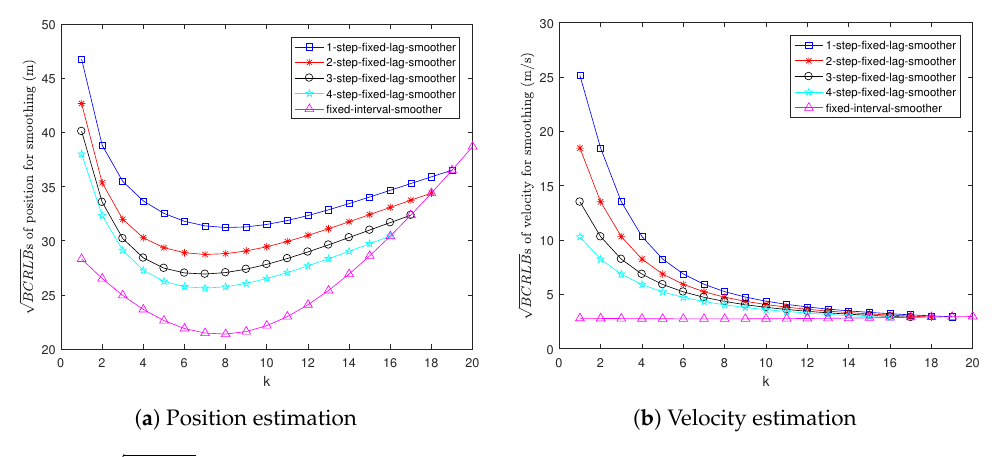
√ Figure 6. BCRLBs for smoothing in Example